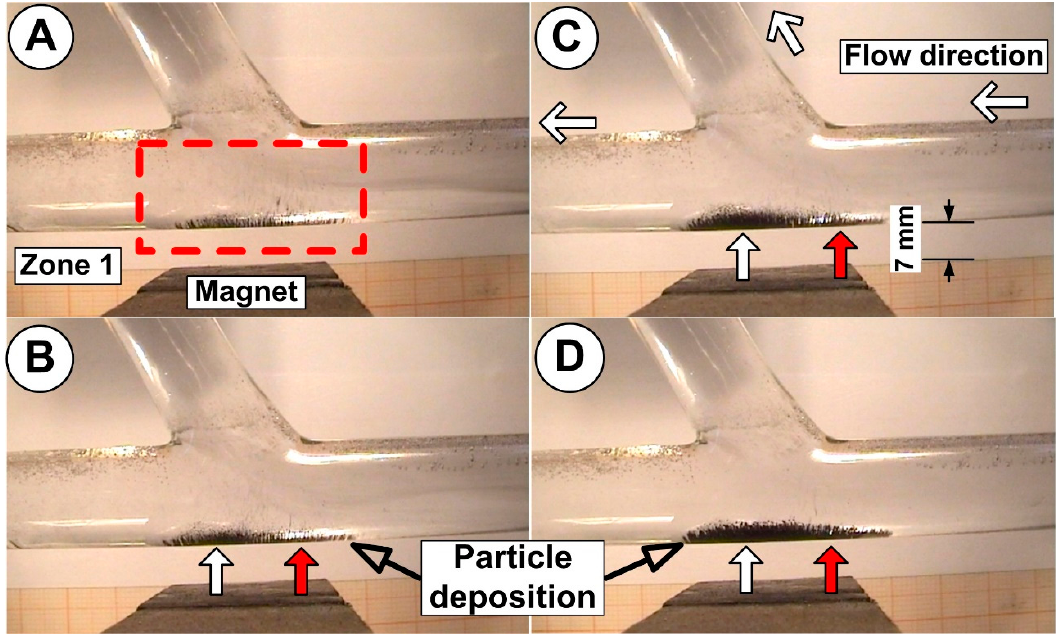
Figure 13. Particle retention in the artery bifurcation during an injection time of 30 s. The distance between the permanent magnet and the bifurcation wall are 7 mm. The average intensity of the magnetic field along the bypass bottom wall was B = 0.05 T, according to Figure 9. Particle deposition at different time steps: ( A ) T = 10 s, ( B ) T = 15 s, ( C ) T = 20 s, ( D ) T = 30 s (end injection). Different thicknesses of the particle deposition in the flow acceleration (red arrow) and deceleration regions (white arrow).